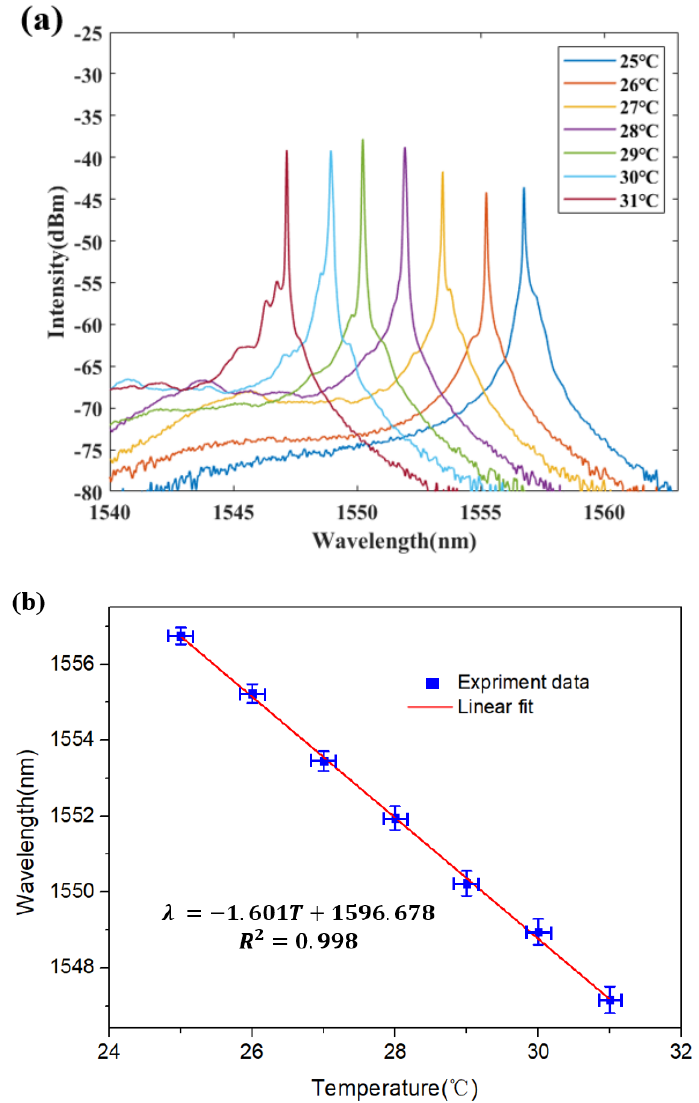
Figure 7. ( a ) Measured output spectra of the 75.5 µ m side-polished fiber temperature sensor at various temperatures; ( b ) Linear relationship of wavelength spacing for 75.5 µ m side polished fiber. The temperature change of the FRL system with polished fiber diameter of 70.9 µ m and the spectral change over the 25–35 ◦ C range are shown in Figure 8a,b. As shown in Figure 8b the emission wavelength shifts from 1565.21 nm to 1545.62 nm, corresponding to a temperature sensitivity of − 1.96 nm/ ◦ C ( R 2 =